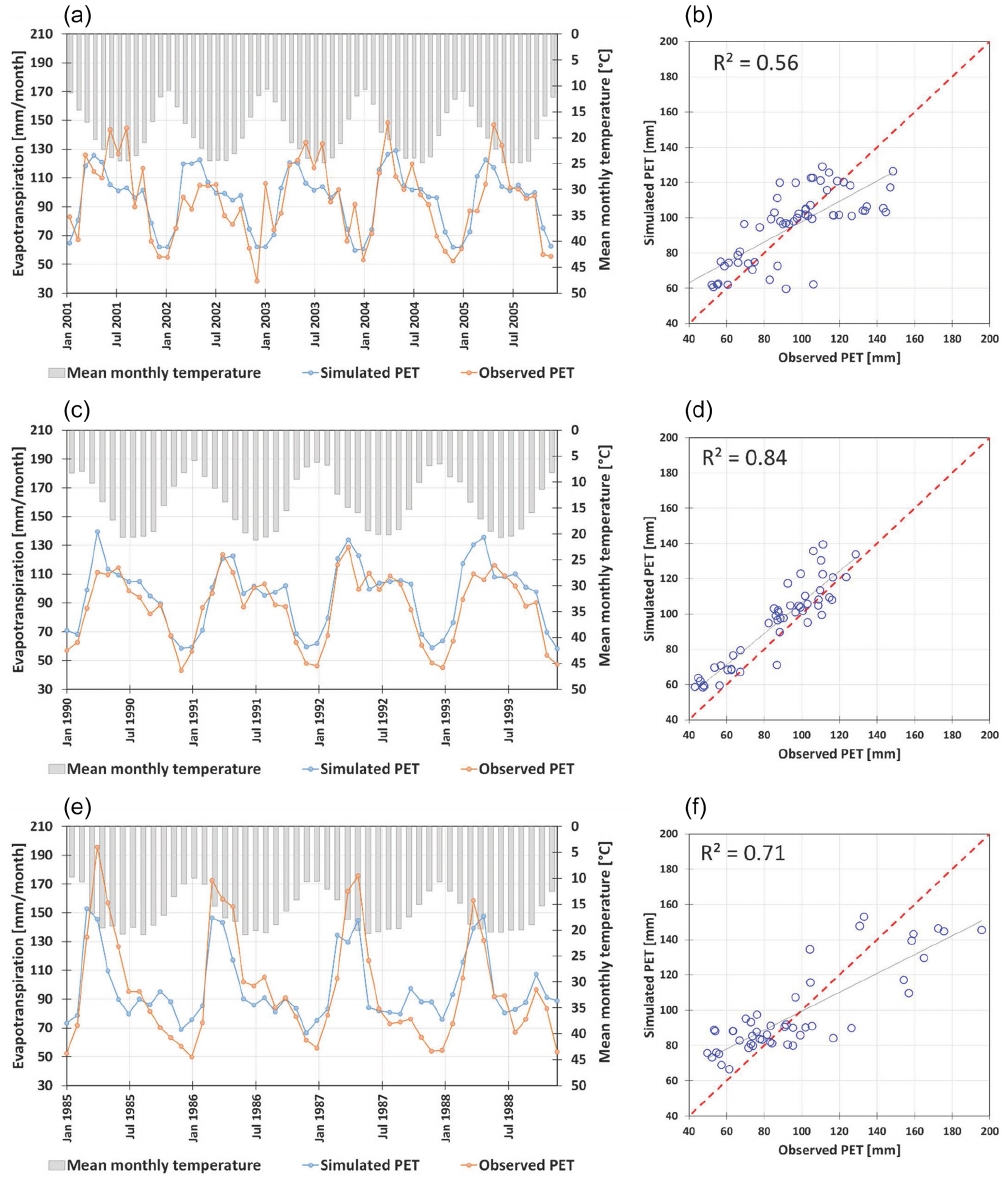
Figure 3. Comparison of monthly potential evapotranspiration for Kathmandu (a, b) , Jiri (c, d) , and Okhaldhunga (e, f)